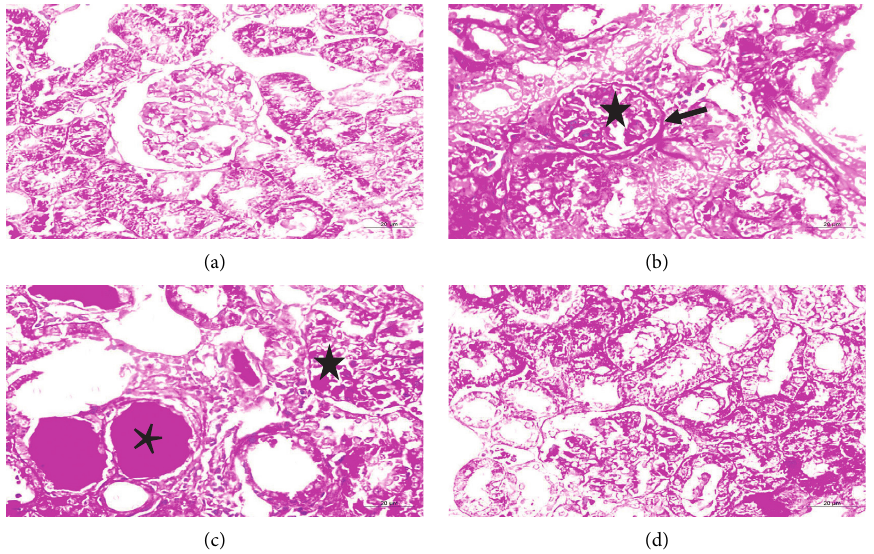
Figure 6: Representative micrographs of PAS-stained renal sections of the different groups under study (a) young; (b, c) sedentary aged (aged-S); (d) exercised aged (aged-Ex); N � 10/group. PAS-stained renal sections of the aged-S rats showed deposition of PAS-positive material within the glomerulus tuft (star) with thickening of the glomerular basement membrane (arrow). Deposition of PAS-positive material, mostly cast formation (asterisk), was also noted. These changes are ameliorated in the aged-Ex group (PAS 40x, scale bar � 20 µ m). N � number of